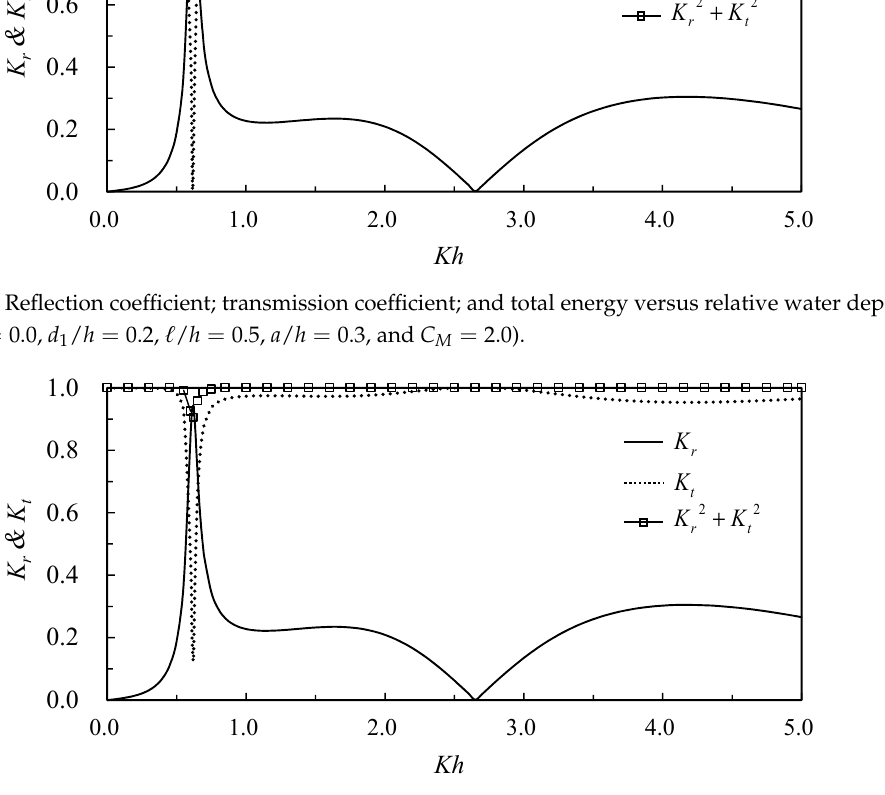
Figure 4. Reflection coefficient; transmission coefficient; and total energy versus relative water depth, Kh ( C D = 2.0, d 1 / h = 0.2, (cid:96) / h = 0.5, a / h = 0.3, and C M =